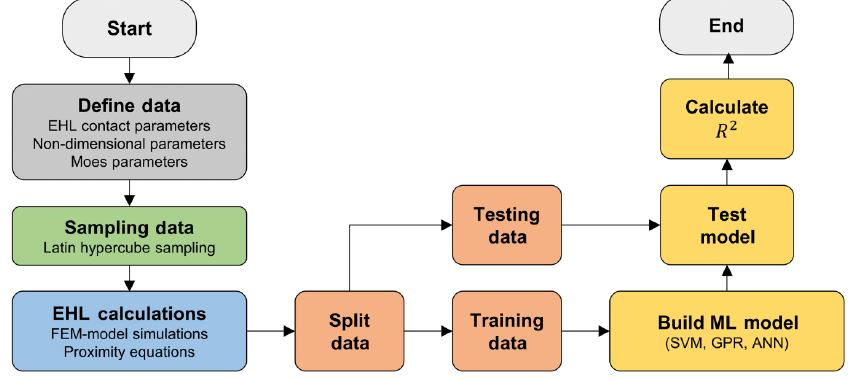
Fig. 3 Flowchart of the ML methodology proposed in the present